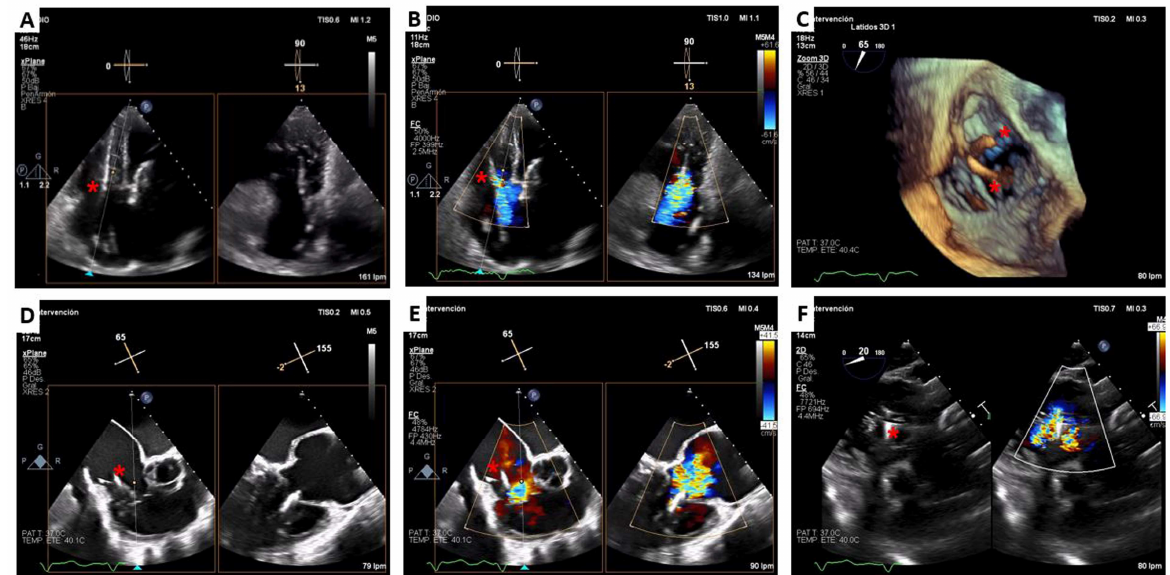
Figure 6. LuX-Valve Plus case. Pre-procedural transthoracic and transesophageal echocardiography. Torrential tricuspid regurgitation ( B , E , F ) secondary to annulus dilatation and leads interference ( A , C , D ). Red star: abandoned VVI pacemaker lead and functionally ICD lead.